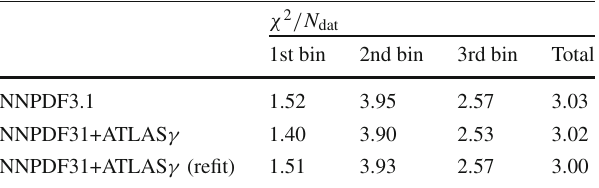
Table 9 The values of the χ 2 per data point including the informa- tion on the correlation of systematic uncertainties. We show the results for three fits: the baseline NNPDF3.1, the NNPDF3.1 + ATLAS γ fit presented in Sect. 4, and the corresponding fit using the correlated χ 2 for the minimisation (labelled as “refit”) and shown in Fig. 13. Note that the first two of these fits have been obtained from the minimisation of χ 2 which does not include the information on the correlations of systematic uncertainties χ 2 / N